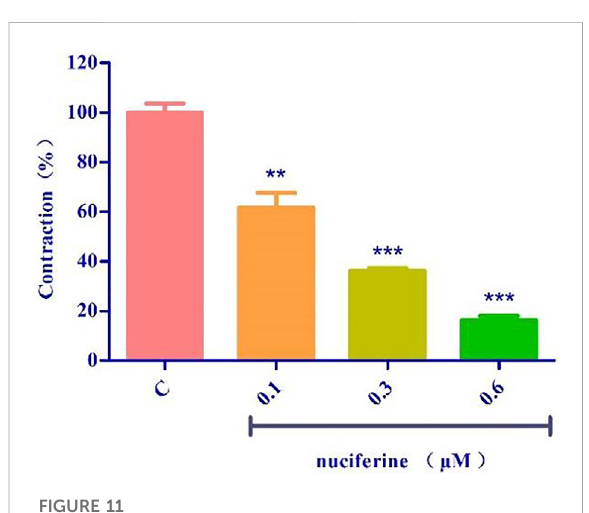
Effects of SR calcium release on nuciferine induced vasorelaxation. The data are expressed as the means ± SD of 6 – 8 rats ( n = 6 – 8). (** p < 0.01 and *** p < 0.001 vs. control